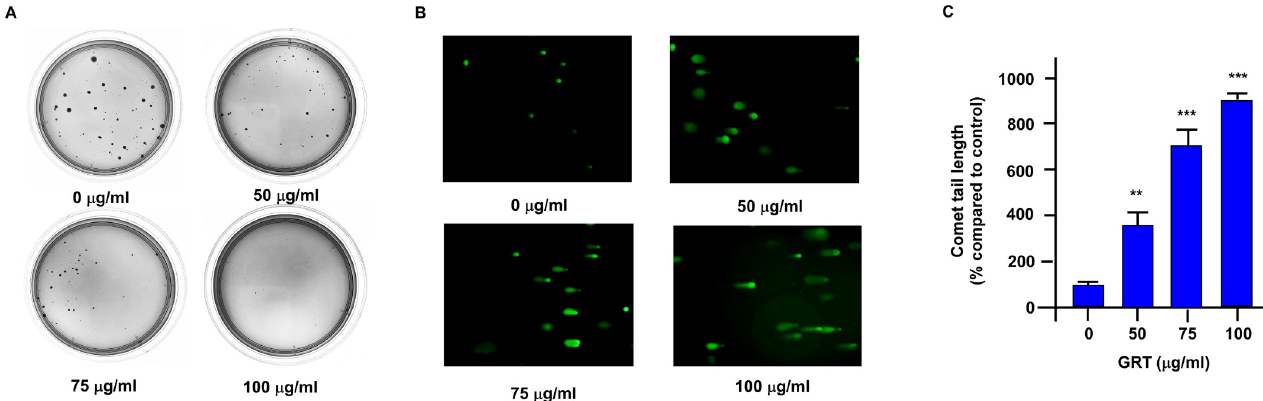
Fig 3. GRT treatment reduced soft agar colony formation of C4-2 MDV3100r cells and induced apoptosis. (A) Anticancer activity of GRT on C4-2 MDV3100r cells was confirmed by measuring the formation of colonies on soft agar for C4-2 MDV3100r cells being treated with GRT (0, 50, 75 and 100 μ g/ mL, being added into the medium). The culture medium was changed twice a week for four weeks. (B) DNA damage caused by GRT treatment in C4-2 MDV3100r cells was determined using the Comet assay. Green fluorescent indicated broken DNA fragments in C4-2 MDV3100r cells being treated with increasing concentration of GRT (0, 50, 75, 100 μ g/ml). (C) Tail extent moment of C4-2 MDV3100r cells in Comet assay was quantified. Data wa presented as mean ± SD in triplicate experiments. Asterisk �� and ��� represents statistically significant difference p < 0.01 and p < 0.001, respectively, between the two groups of cells being compared.